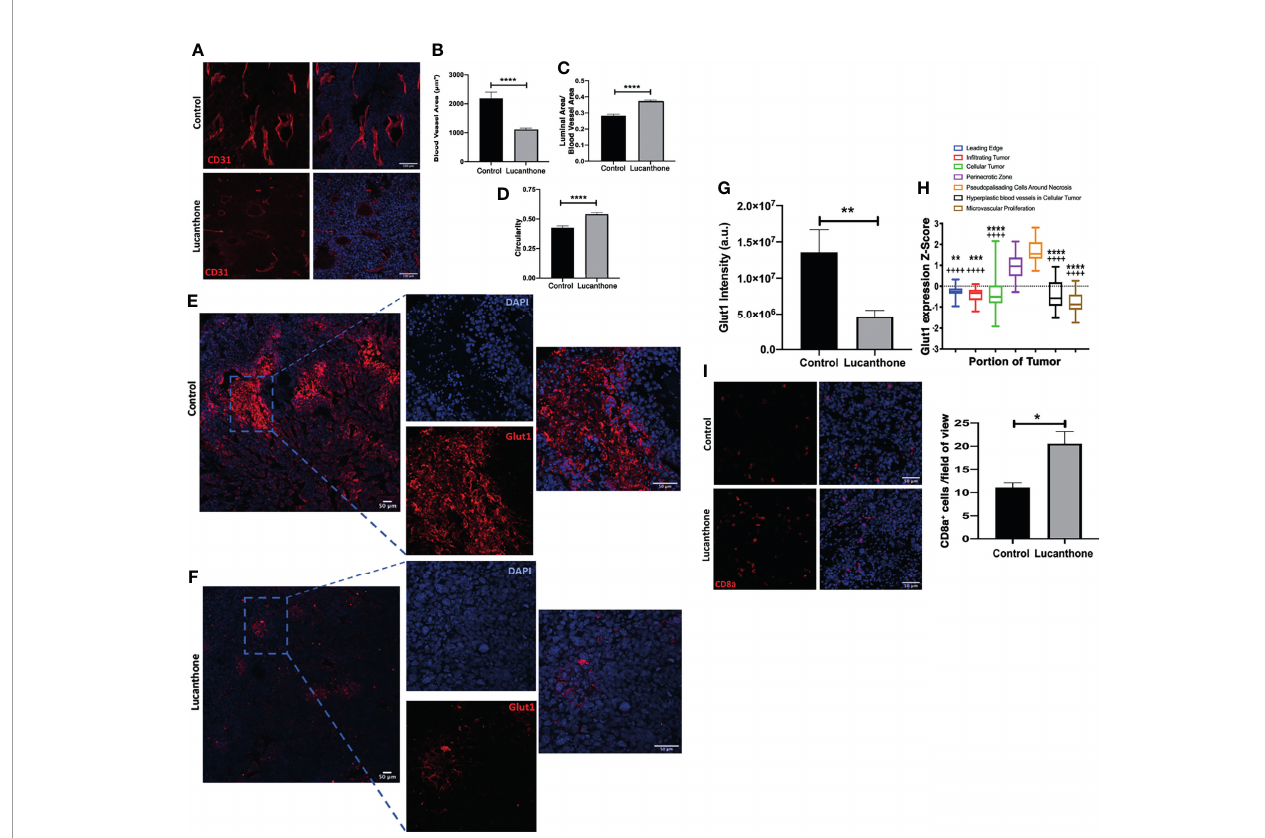
FIGURE 7 | Tumor microenvironmental changes induced by Lucanthone. (A) Representative images of blood vessels marked by CD31 of control- and lucanthone- treated tumors. (B) Blood vessel area. (C) Luminal area/blood vessel area. (D) Blood vessel circularity. ****p < 0.0001, Kolmogorov-Smirnov test. Bars are mean +/- SEM, N=4-5 animals per group. (E, F) Representative images of Glut1 levels in control- and lucanthone-treated tumors, respectively. (G) Quanti fi cation of Glut1 intensity in the tumor microenvironment. Bars are mean +/- SEM. N=5 mice **p < 0.01, t-test. (H) Glut1 expression in necrotic areas in clinical specimens. Data adapted from the Ivy Glioblastoma Atlas. ****p < 0.0001, Kruskal Wallis test. **p < 0.01, ***p < 0.001, ****p < 0.0001, Dunn ’ s test, compared to perinecrotic zone, ++++ p < 0.0001, Dunn ’ s test, compared to pseudopalisading cells around necrotic areas. (I) CD8a + cells in the tumor microenvironment in control- and lucanthone-treated tumors. *p < 0.05, Mann-Whitney test Bars are mean +/- SEM, N=4 animals per